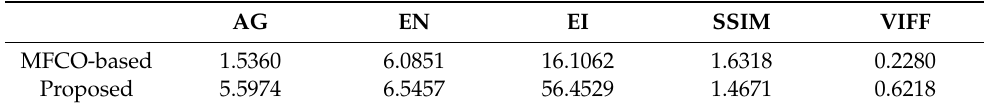
Table 6. Objective analysis for two FPGA-based fusion method in the two scenes. AG EN EI SSIM VIFF MFCO-based 1.5360